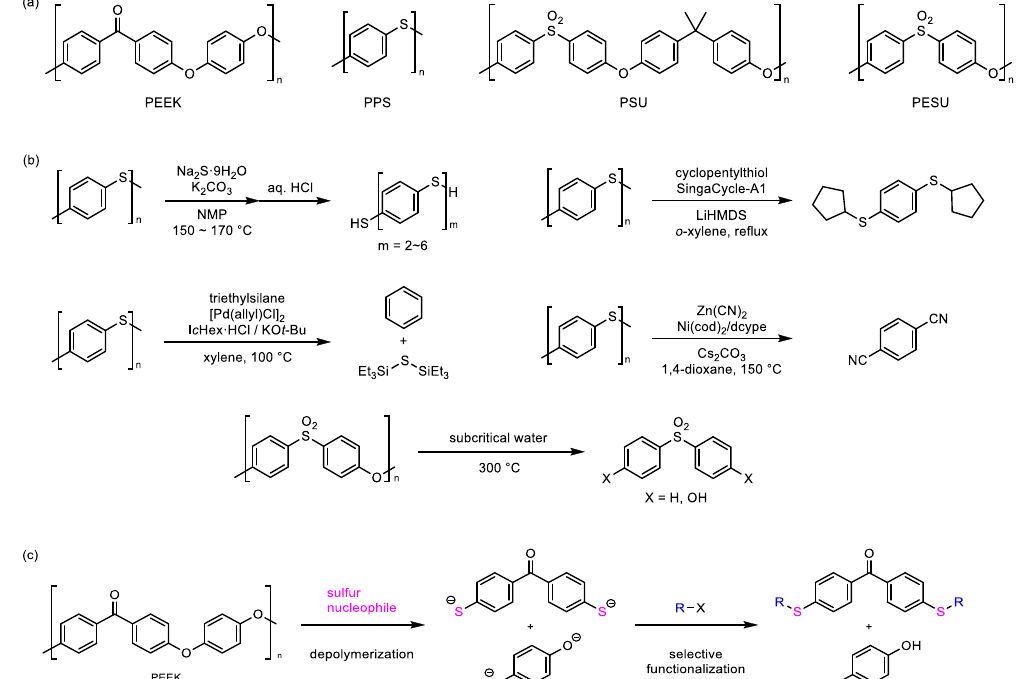
Fig. 1 Depolymerization of super engineering plastics. a Examples of super engineering plastics. b Reported depolymerization of PPS or PESU to produce low-weight molecules. c This work: PEEK depolymerization using sulfur nucleophiles to afford two anionic monomer intermediates, followed by selective functionalization with organic halides produced dithiofunctionalized benzophenones and hydroquinone. NMP, N -methyl-2-pyrrolidone;